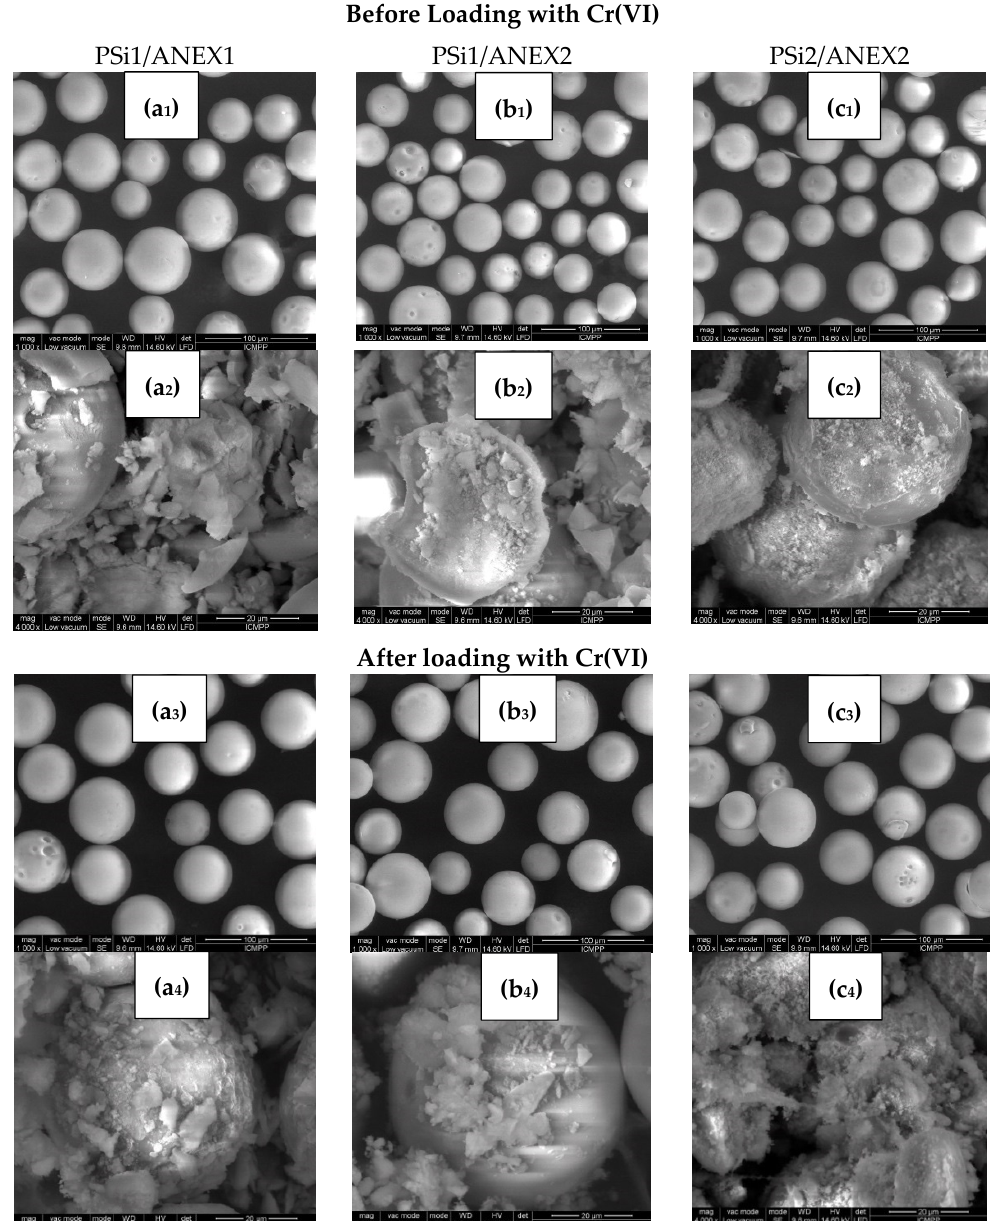
Figure 3. SEM images of the exterior (mag 1000×), and the interior morphology (mag. 4000×) of the PSi/ANEX composites before loading with Cr(VI) of the PSi1/ANEX1 ( a 1 and a 2 ), PSi1/ANEX2 ( b 1 and b 2 ), PSi2/ANEX2 ( c 1 and c 2 ) composites, and after loading with Cr(VI) of PSi1/ANEX1 ( a 3 and a 4 ), PSi1/ANEX2 ( b 3 and b 4 ), and PSi2/ANEX2 ( c 3 and c 4 ).